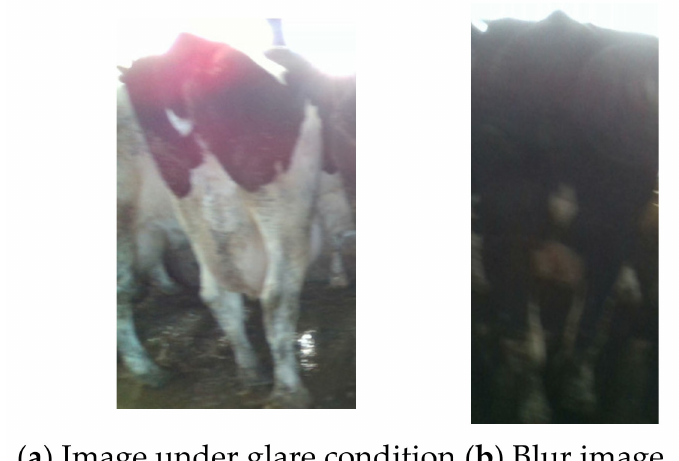
Figure 6. Incorrect detection